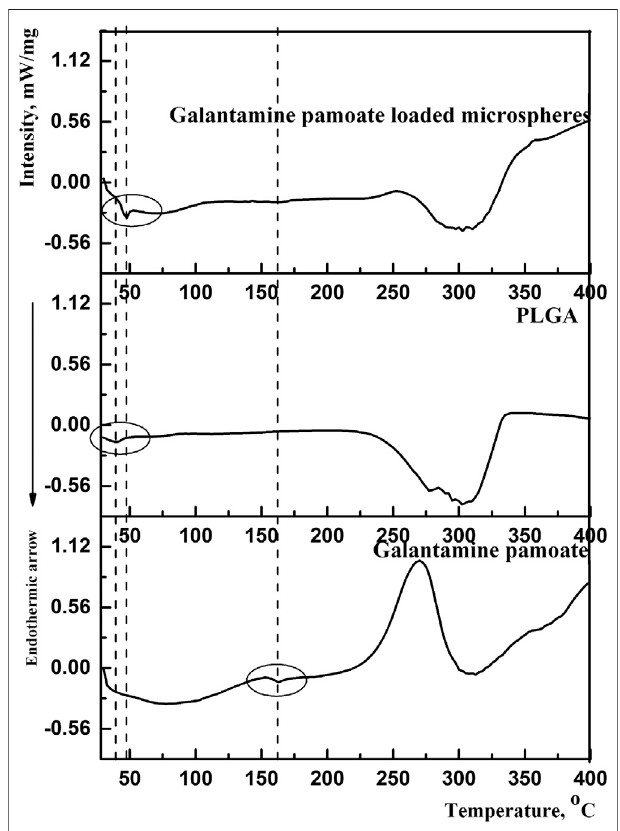
FIGURE 5 | DSC curves of GLT-PM, PLGA and GLT-PM-MS.